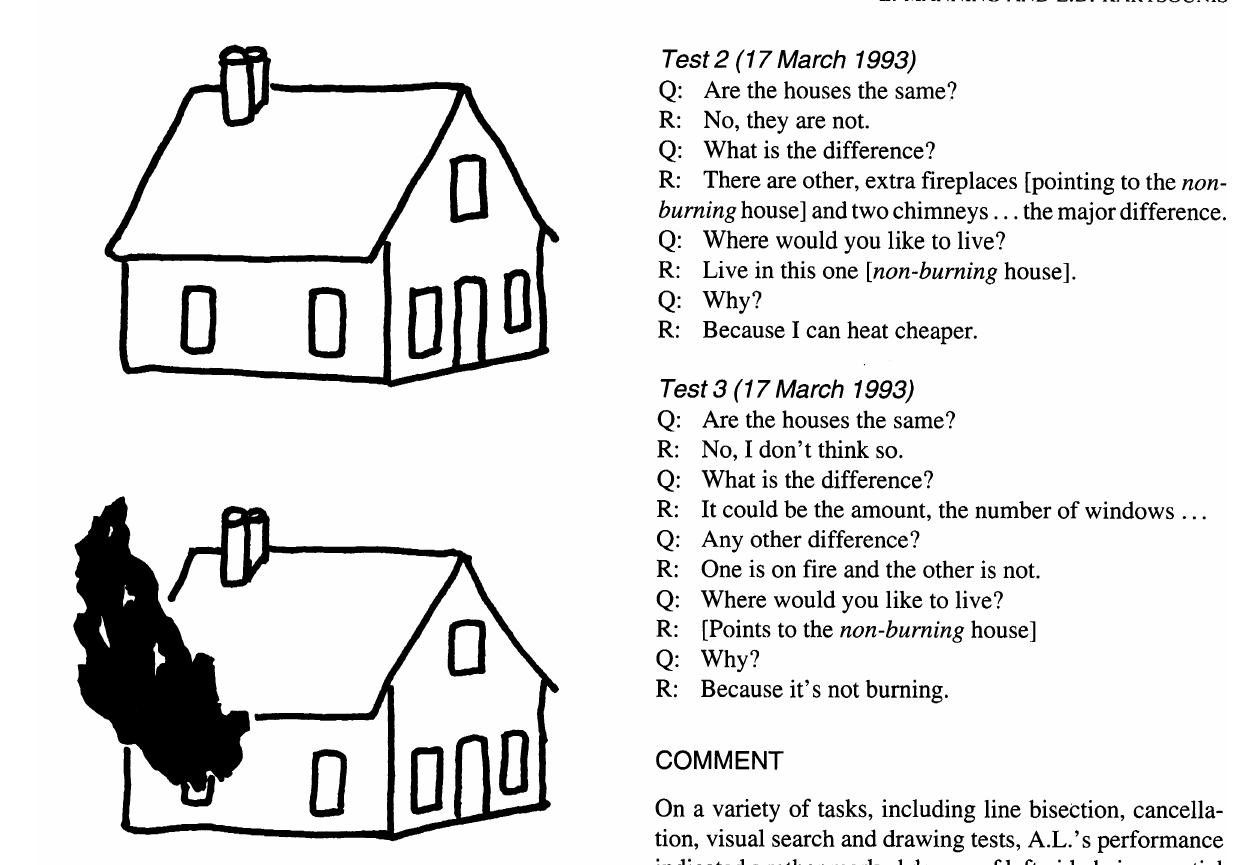
FIG. 1. The "burning house tesf' (adapted from Marshall and Halli gan, 1988 and Bisiach and Rusconi, 1990).